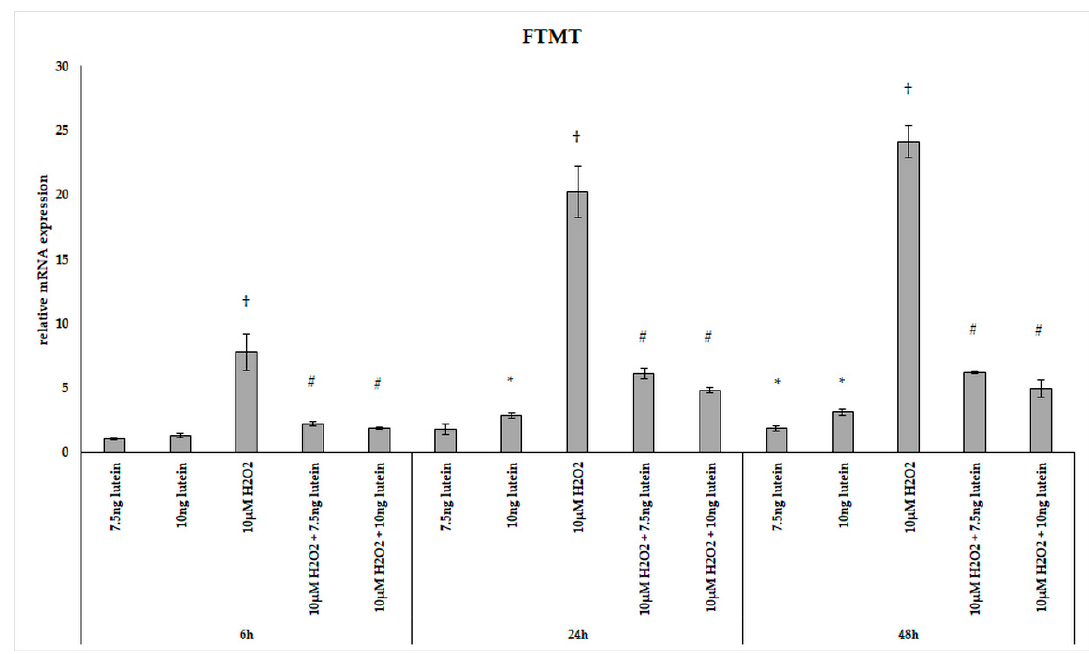
Figure 10. Effects of lutein and H 2 O 2 on FTMT mRNA expression. The columns represent the mean values, and error bars indicate the standard deviation (SD) of three independent experiments ( n = 3), each performed in triplicate, and are presented relative to own control cells. * indicates statistical significance of lutein treatments versus controls; † indicates statistical significance of H 2 O 2 -treated cells compared to controls; # indicates statistical significance of combined (lutein with H 2 O 2 ) treatments compared to H 2 O 2 treatments; the level of significance was p < 0.05. Real-time PCR was performed with the SYBR green protocol using gene-specific primers. β -actin was used as house-keeping gene for the normalization. The relative expression of controls was regarded as 1.